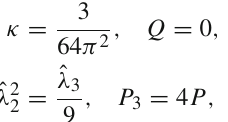
(cid:12) (cid:13) ˆ λ h 2 (lower panel) as a function of h 2 for the fixed value ˆ λ 3 = 1 (cid:13) (cid:12) 2 h 2 (upper panel) and as blue solid line. The red dashed lines correspond to the leading-order constant solutions highlighted in Eqs. (46) and